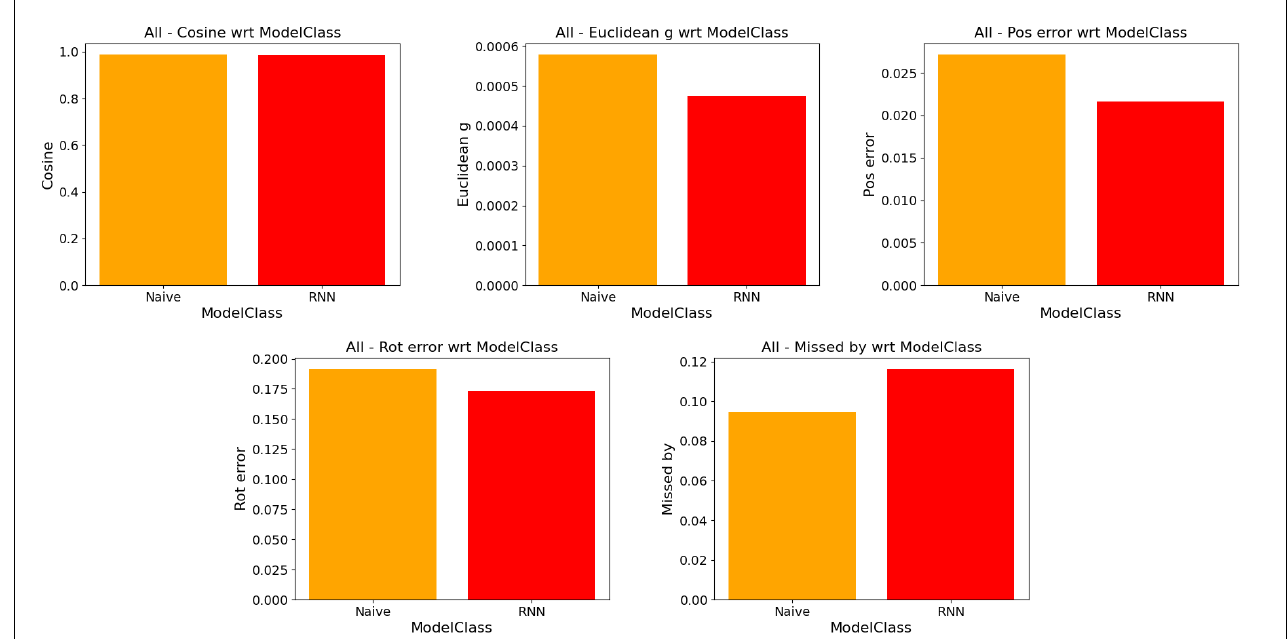
Figure 6. Results—comparison between model architectures ( Naive —refers to the feedforward architecture, also “naive behavioral cloning”), the best performance attained in each class. Top row metrics—cosine similarity (dimensionless), Euclidean distance (all features, no specific unit); mean position error (stepwise, meters). Bottom row—mean rotation error (stepwise, radians), mean throw error